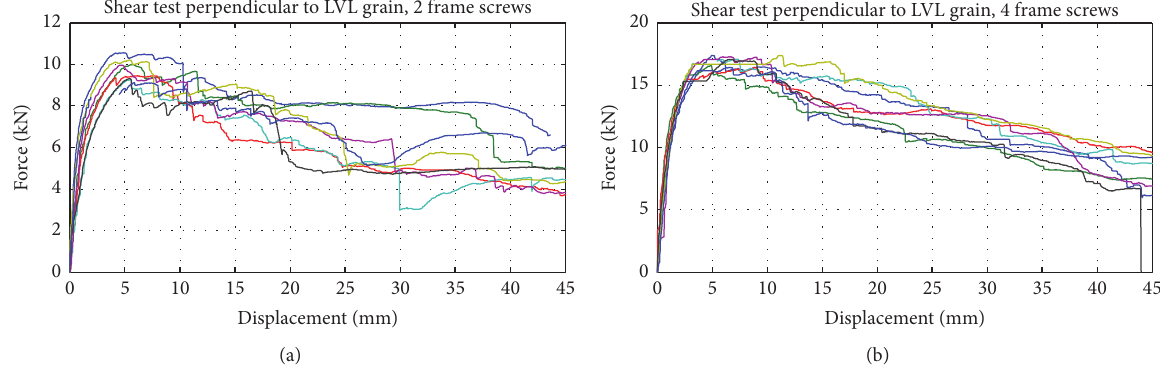
Figure 9: Load-displacement graphs for the shear tests with (a) 2 screws and (b) 4 screws per connection.